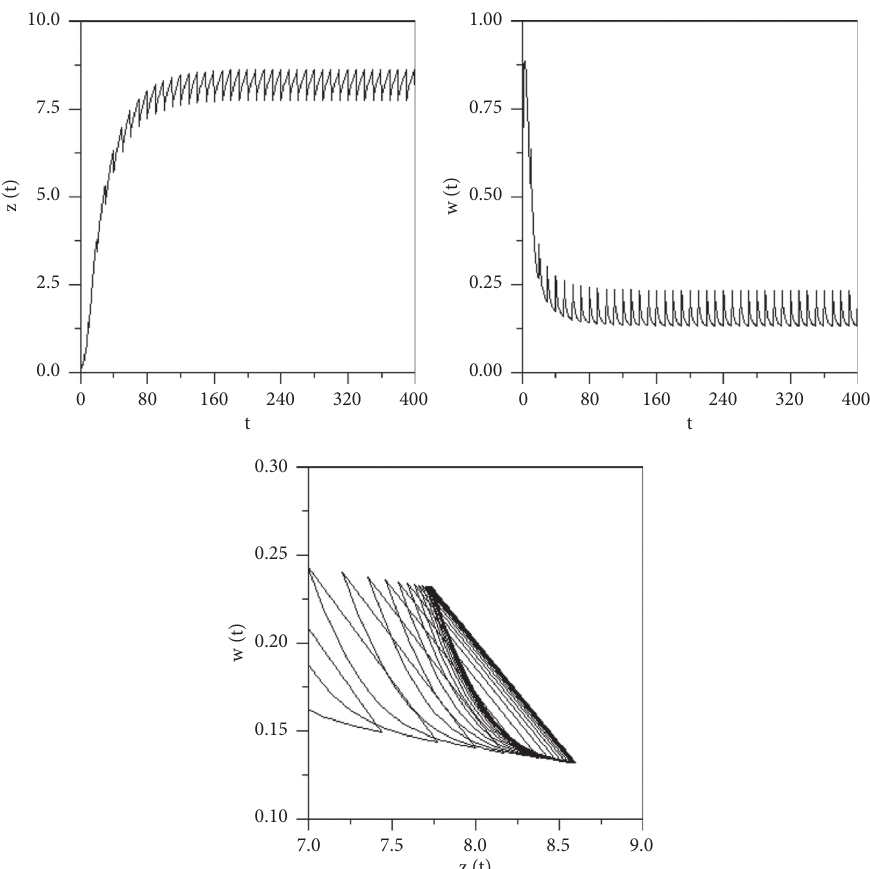
Figure 3: A computer simulation of systems (5) and (6). The solution exhibits sustained oscillations. Here, a � 0 . 19 ,a � 0 . 39 , a 0 . 58 , a 3 4 � 0 . 96 , k � 0 . 2 ,k � 0 . 84 , k 4 5